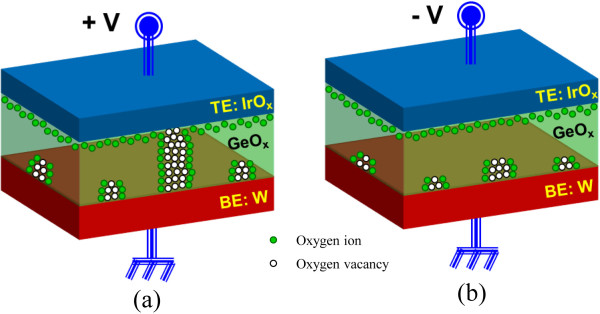
Formation (a) and oxidation (b) of Ge/GeOx nanofilaments under SET and RESET operations. Ge/GeOx nanowires can be formed under SET and it is dissolved under RESET operations.